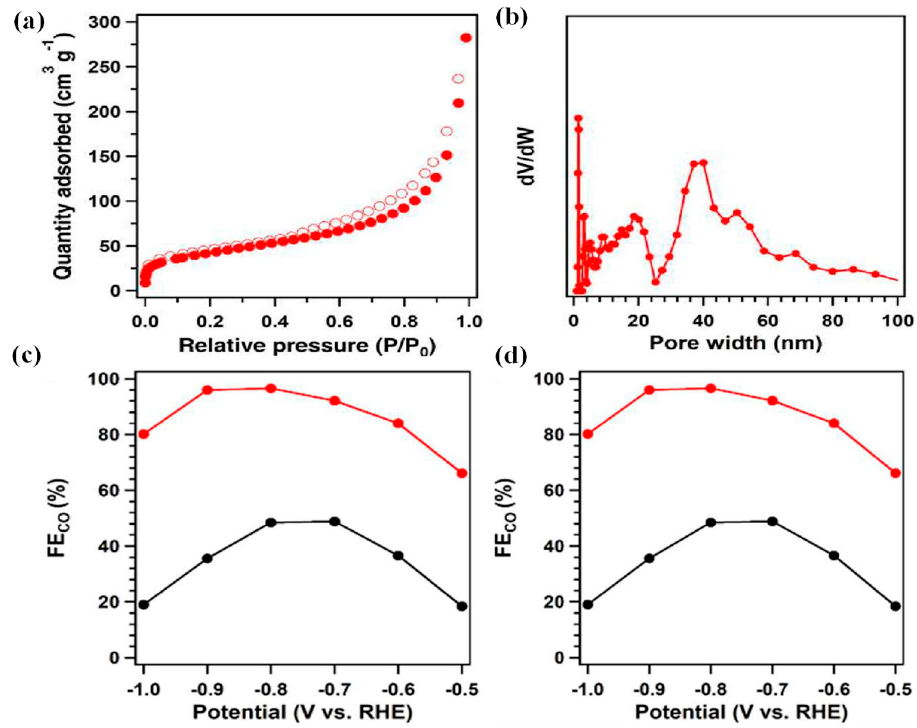
Figure 11. ( a ) BET plot of 2D − Co − COF500; ( b ) pore distribution; ( c ) the FEs of CO; ( d ) the current density of CO [94]. Reprinted with permission from Ref. [94]. Copyright 2022 Copyright Elsevier (Amsterdam, The Netherlands).